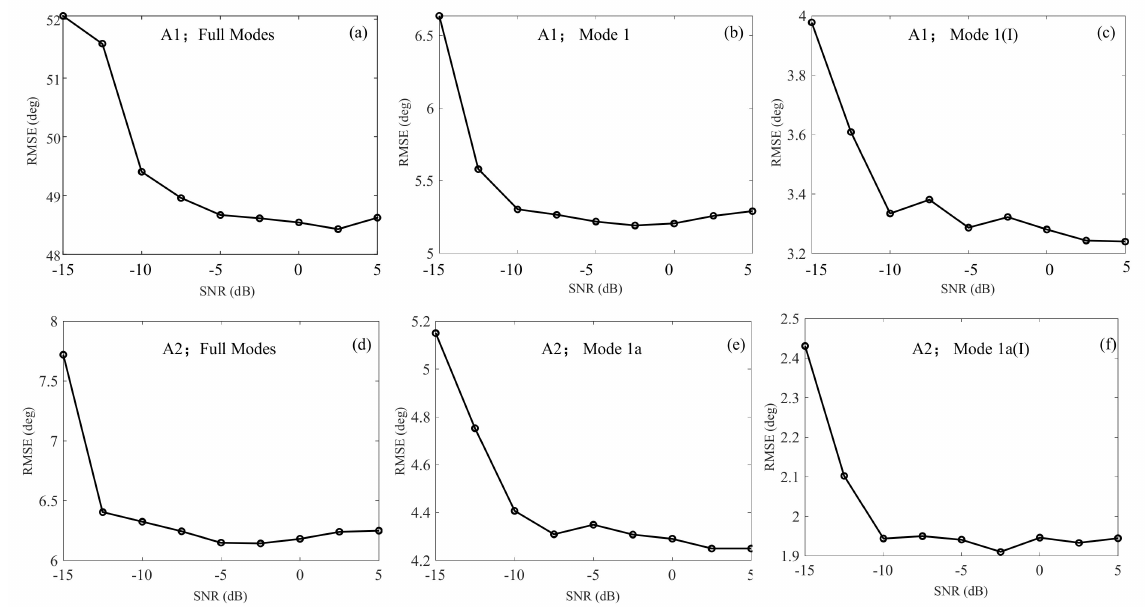
Figure 7. RMSE under several SNRs for A1 site using ( a ) full modes; ( b ) the direct arrival of mode 1; and ( c ) the first packet of the direct arrival of mode 1; RMSE under several SNRs for A2 site using ( d ) full modes; ( e ) the direct arrival of mode 1; and ( f ) the first packet of the direct arrival of mode